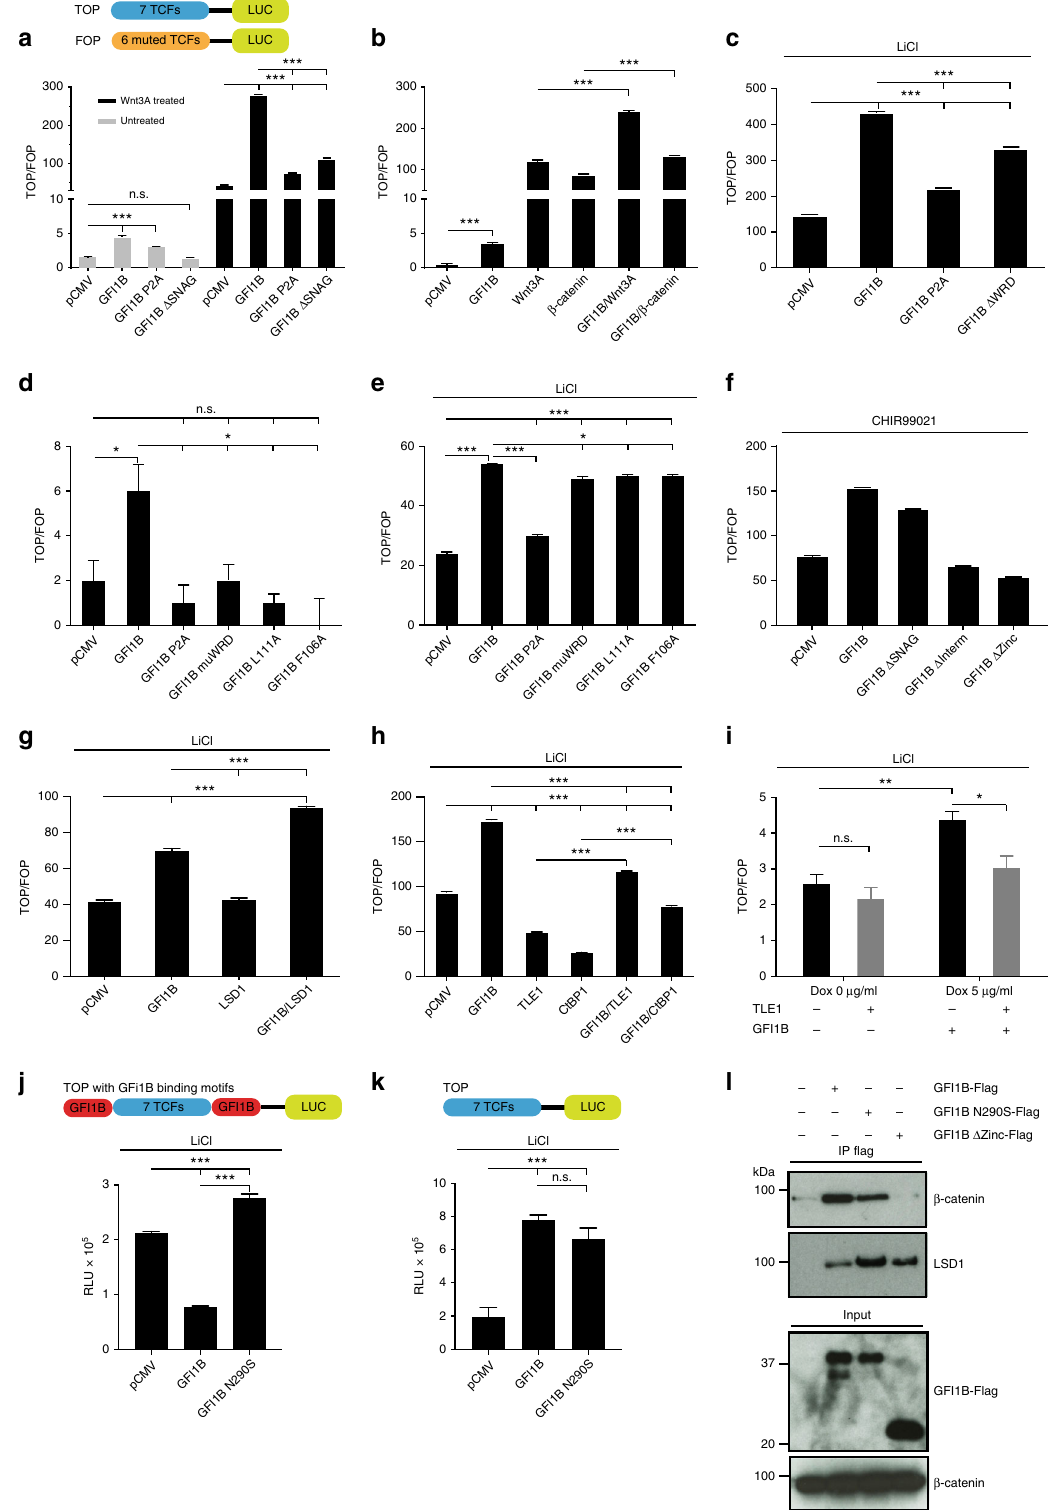
three cell subsets and was statistically signi fi cant in MKs (Fig. 5c). To validate this, we used a second in vivo reporter system, the TCF/LEF:H2B-GFP transgene reporter mice, in which six copies of a TCF/LEF responsive element are placed directly 5 ′ of a his- tone H2B-GFP fusion gene 36 . Similar to the Axin2 LacZ reporter system, a reduction of GFP intensities was observed in HSCs